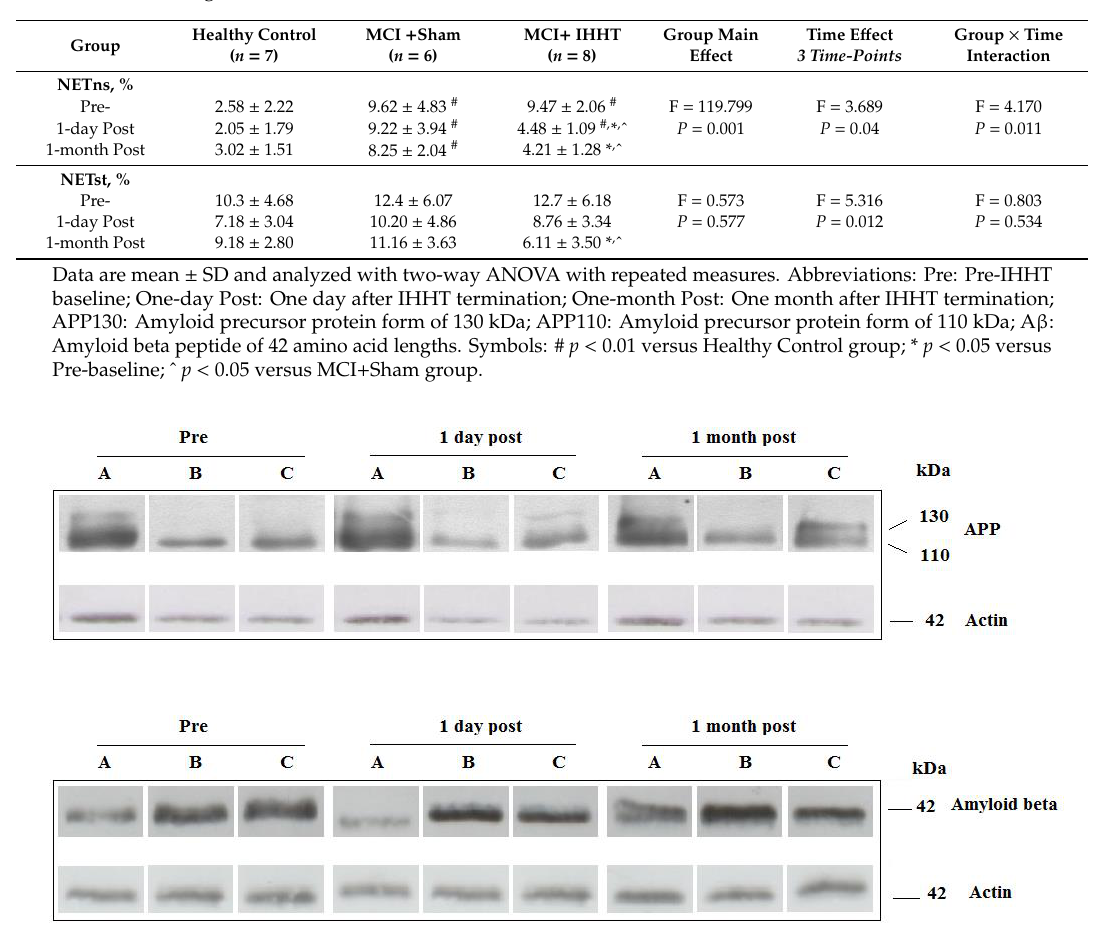
Table 3. Platelets amyloid precursor proteins (APP) and amyloid beta (A β ) under three-week sessions of sham training or IHHT.